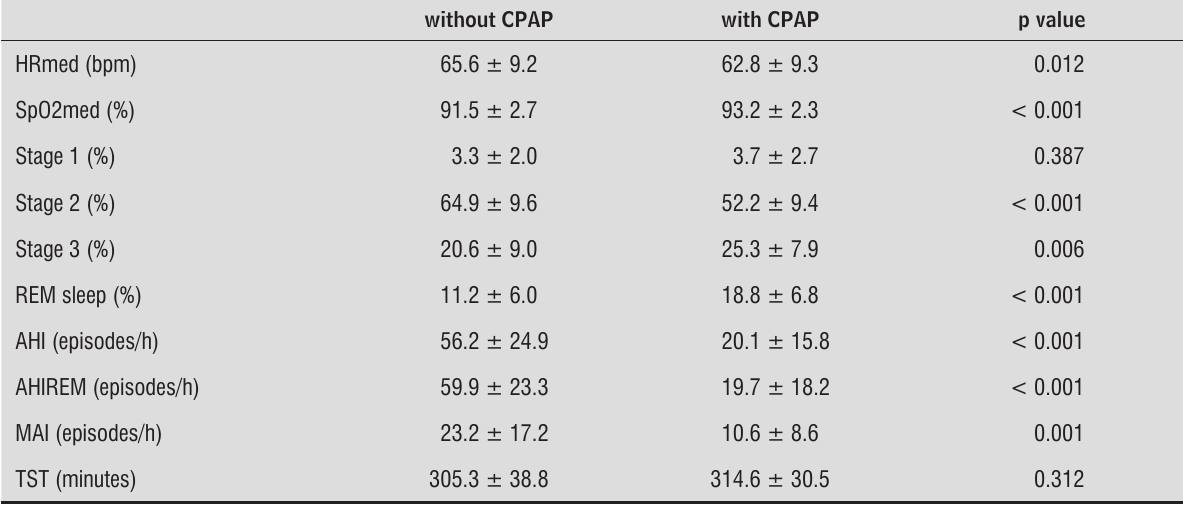
Table 1 - Physiological and polysomnography values with and without use of CPAP without CPAP with CPAP p